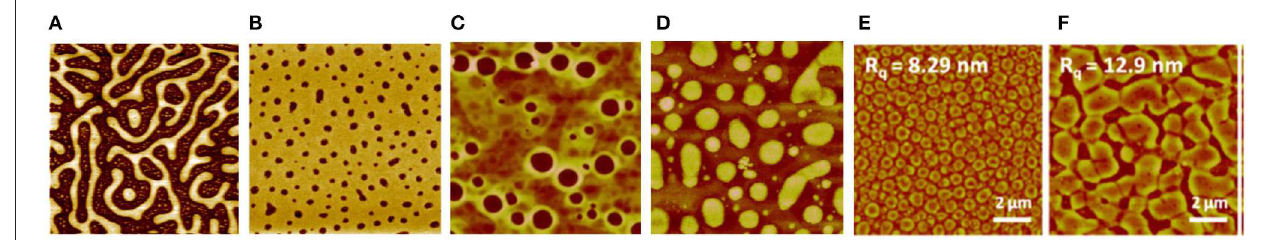
FIGURE 4 | AFM images of blend films of cellulose, regenerated from TMSC with other polymers at following ratios: (A) TMSC/PS 2:1, 20 × 20 µ m 2 scan as in reference (Reproduced from Kontturi et al., 2005b with permission from American Chemical Society); (B) TMSC/PMMA 1:7, 5 × 5 µ m 2 scan (Reproduced from Kontturi et al., 2009 with permission from Royal Society of Chemistry); (C) TMSC/CTA 1:2, 5 × 5 µ m 2 scan (Reproduced from Taajamaa et al., 2011 with permission from Royal Society of Chemistry); (D) same film as in (C) but CTA has been removed with a selective solvent, 5 × 5 µ m 2 scan (Reproduced from Taajamaa et al., 2011 with permission from Royal Society of Chemistry); (E) TMSC/CSE 3:1, 10 × 10 µ m 2 scan (Reproduced from Niegelhell et al., 2017 with permission from American Chemical Society); (F) TMSC/CSE 1:1, 10 × 10 µ m 2 scan (Reproduced from Niegelhell et al., 2017 with permission from American Chemical